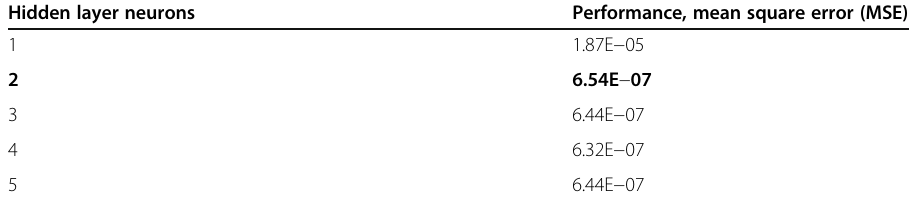
Table 2 QPSO-trained RBFNN performance at different hidden layer neurons Hidden layer